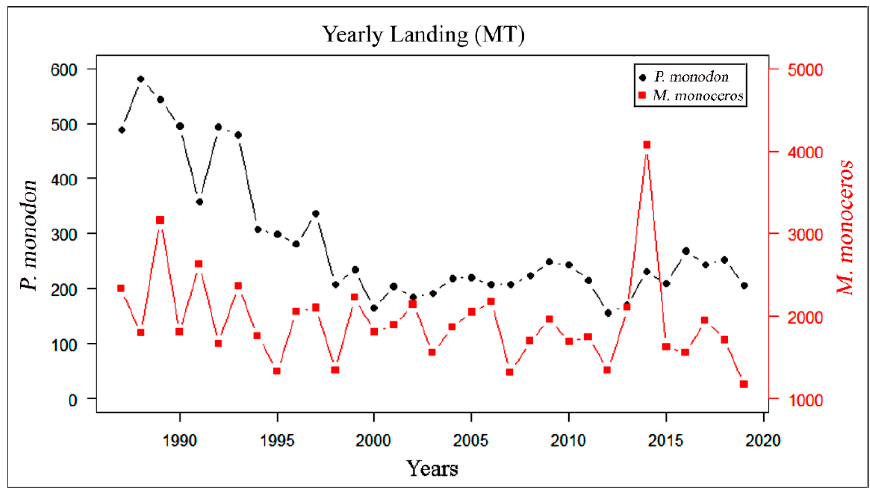
Figure 2. Catches of Penaeus monodon and Metapenaeus monoceros in metric tons from 1987–2019 from industrial trawling in the EEZ of Bangladesh.